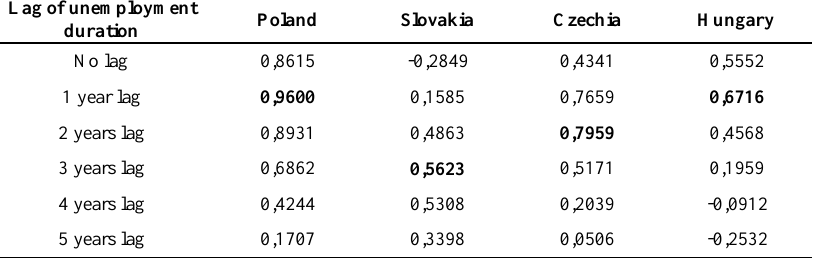
Table 1. Pearson product-moment correlation coefficients between the unemployment rate and lagged median unemployment duration